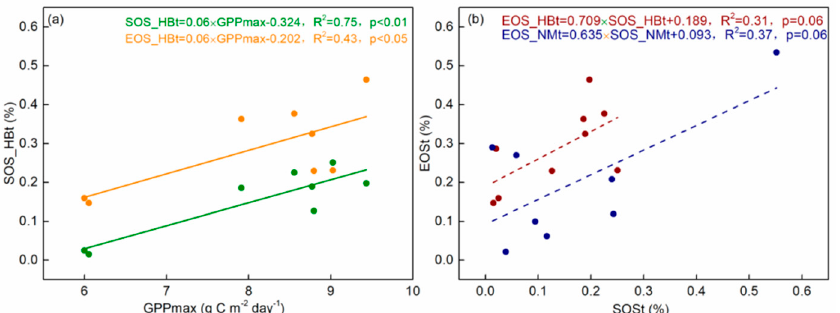
Figure 9. The determination of the thresholds of carbon phenology periods from EC-based maximum GPP observations (GPPmax) in HB ( a ) and the relationship between two thresholds of carbon phenology periods (SOSt and EOSt) in HB and NM sites ( b ). The solid line represents a significant regression relationship ( p < 0.05).